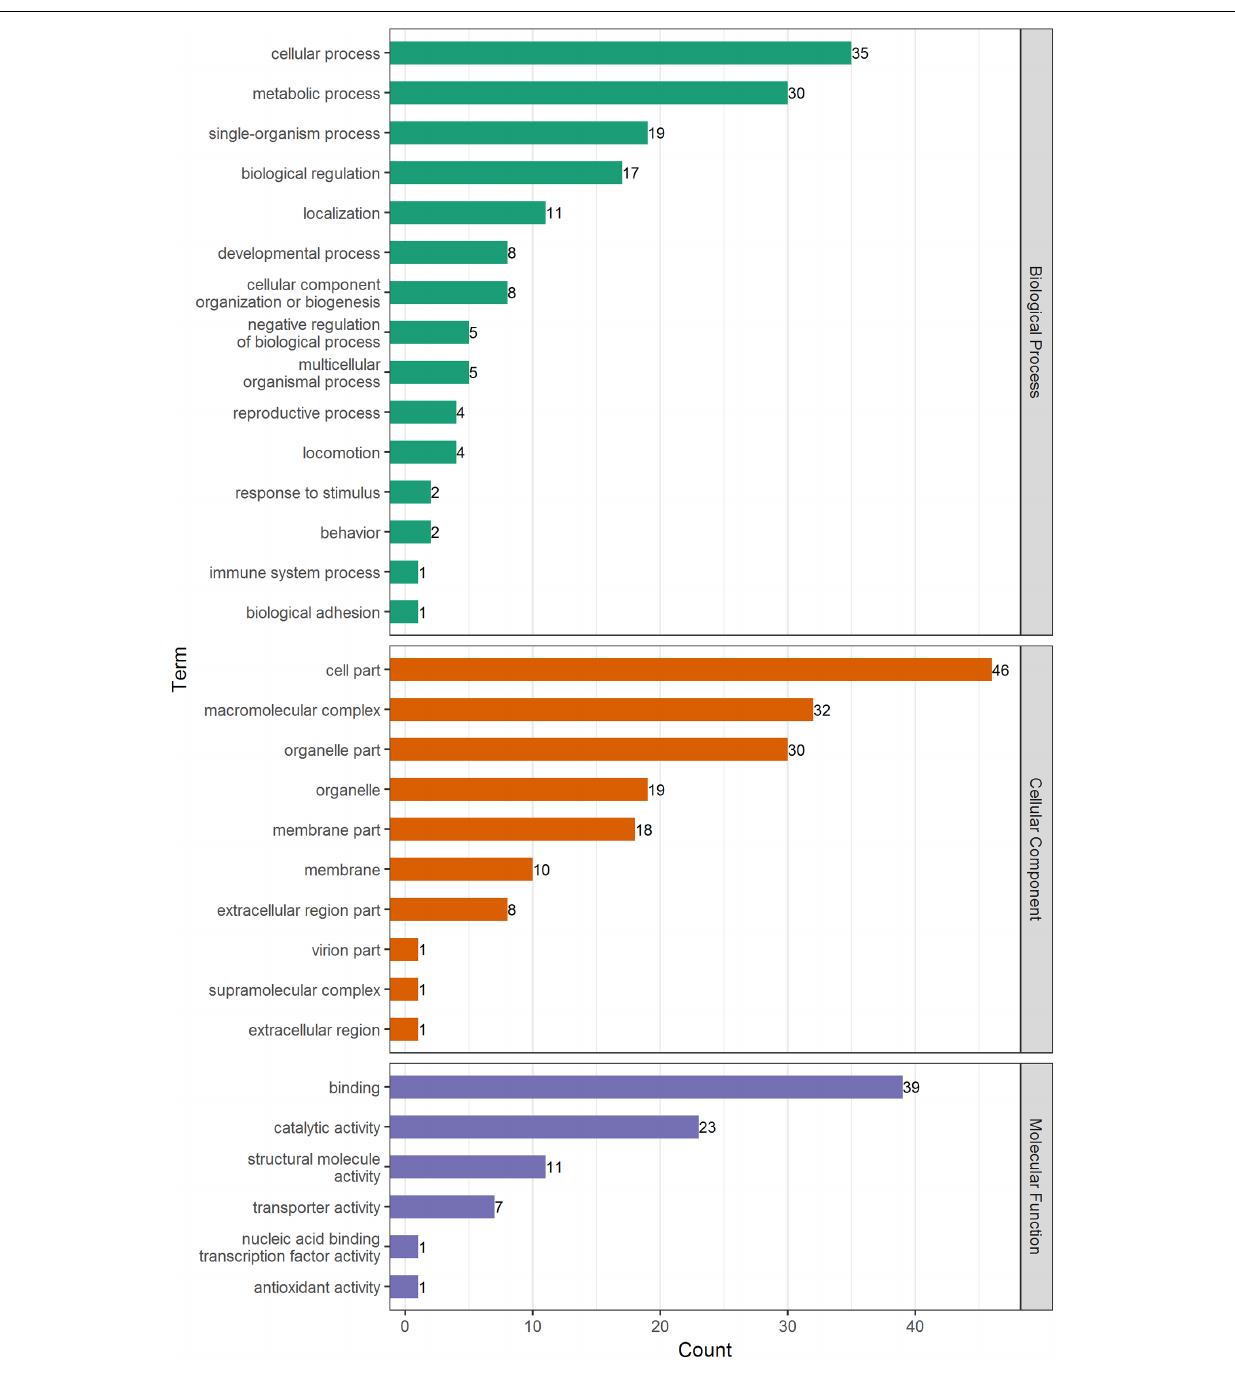
proteins were downregulated in adult worms from water buffalo, suggesting that the lower expression of these spliceosome-related molecules might affect transcriptional processes in schistosomes infecting water buffaloes and lead to the poor development of the